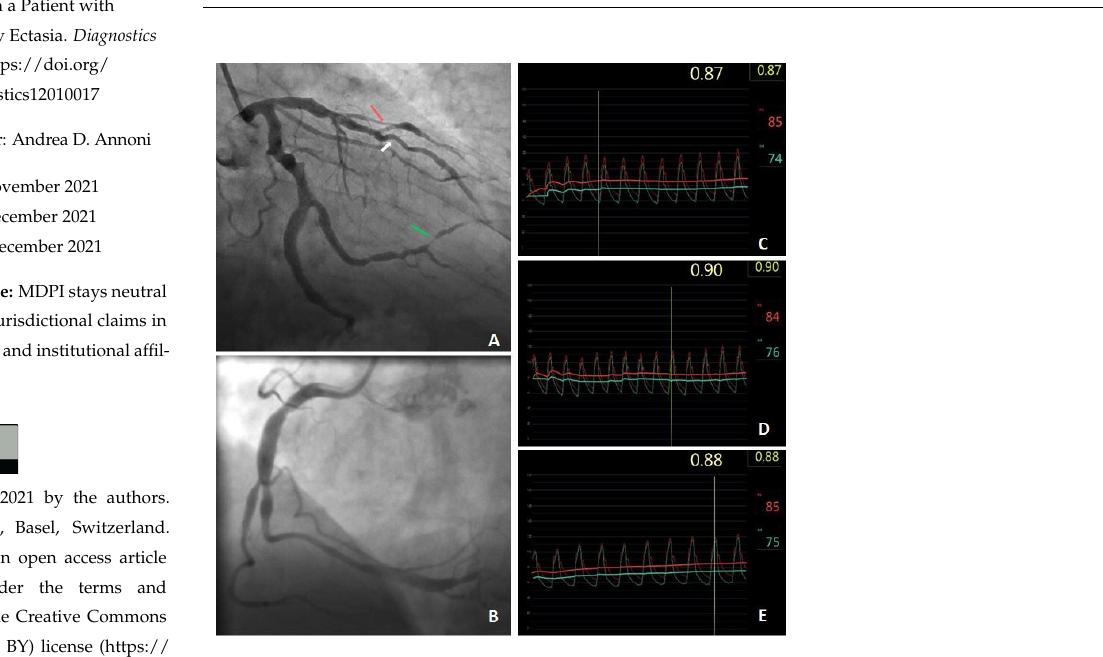
Figure 1. A 69-year-old male patient with arterial hypertension and hypercholesterolaemia, with a one-year history of stress angina and positive electrocardiographic exercise test, was admitted to